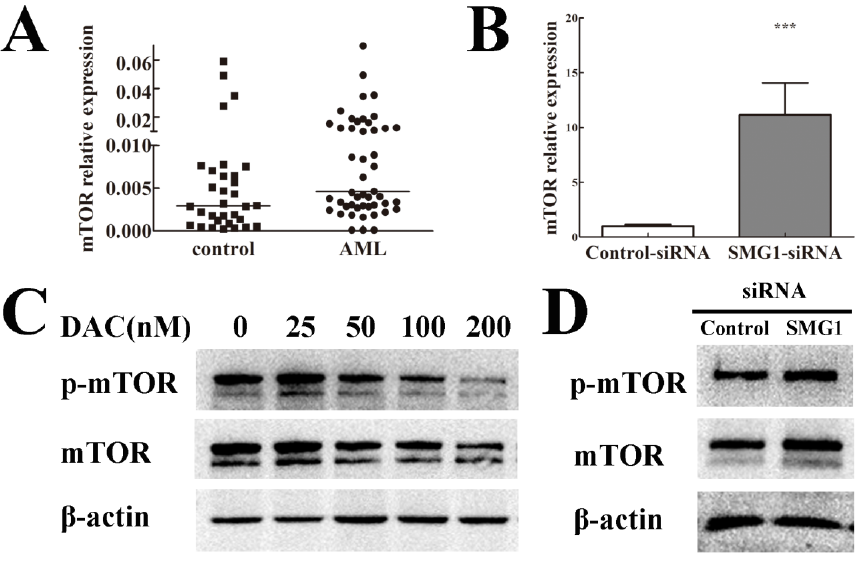
Figure 4. mTOR maybe act antagonistically with SMG1 to regulate cell